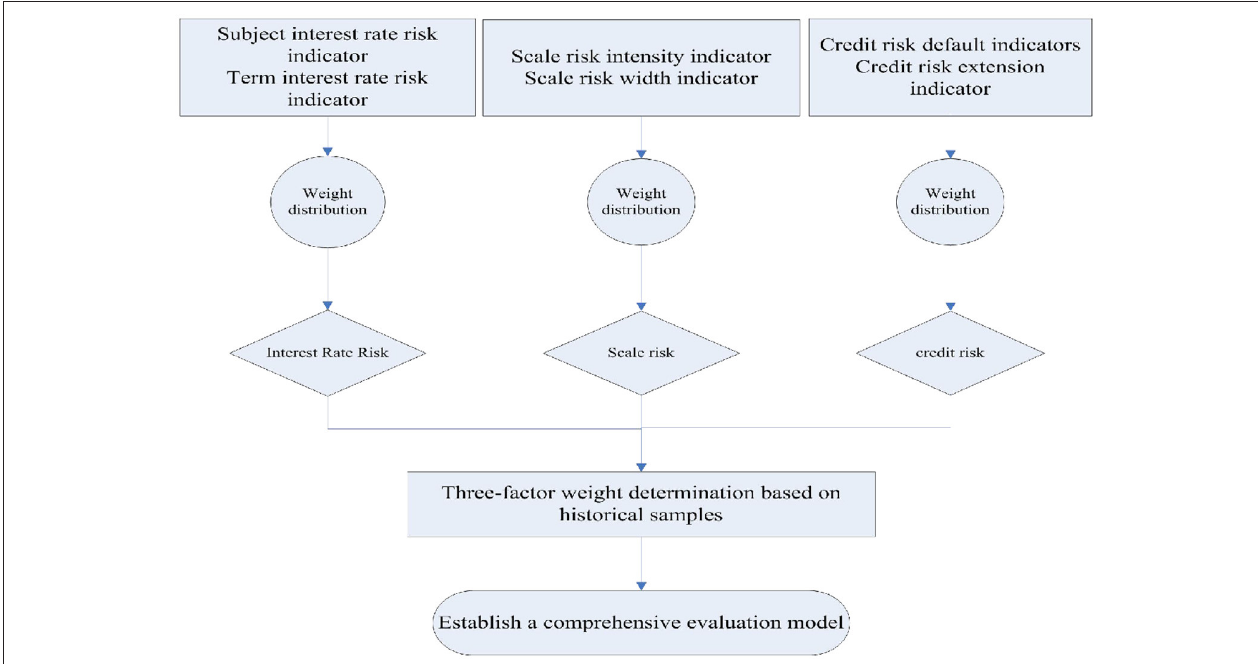
FIGURE 1 | Schematic diagram of the process of establishing a private lending risk model.